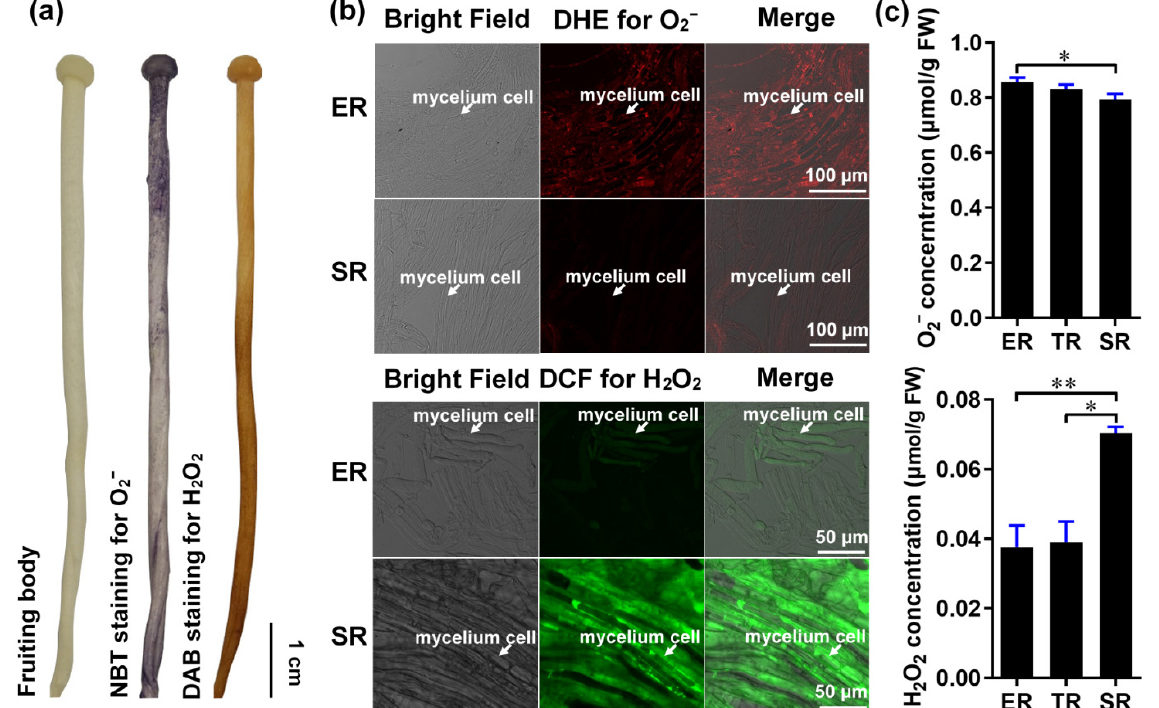
Figure 2. The distribution of ROS (O 2 − and H 2 O 2 ) in the stipe of F. filiformis . ( a ) Histochemical staining with NBT to detect O 2 − (purple) and DAB to detect H 2 O 2 (yellowish-brown). ( b ) Cellular-level fluorescent probe detection with DHE for O 2 − (red fluorescence) and DCF for H 2 O 2 (green fluorescence) in ER and SR region cells (the mycelium cells were marked by white arrows). ( c ) Measurement of the O 2 − ( n = 5) and H 2 O 2 ( n = 3) concentration using spectrophotometry (paired t -test, * p < 0.05, ** p < 0.01).